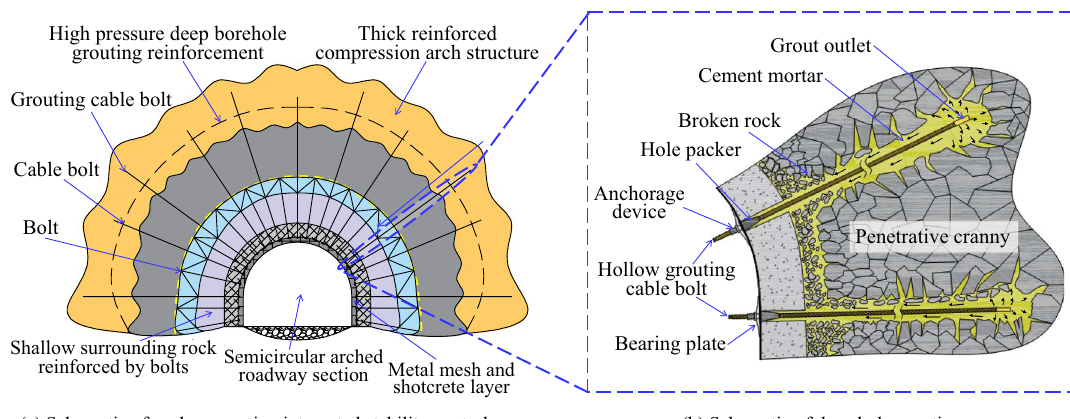
Fig. 19 Principle of the role of anchor-grouting integrated stable control support